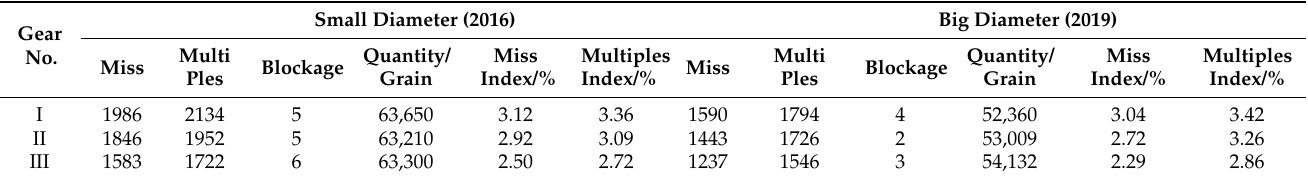
Table 4. Abnormal phenomenon statistics in field